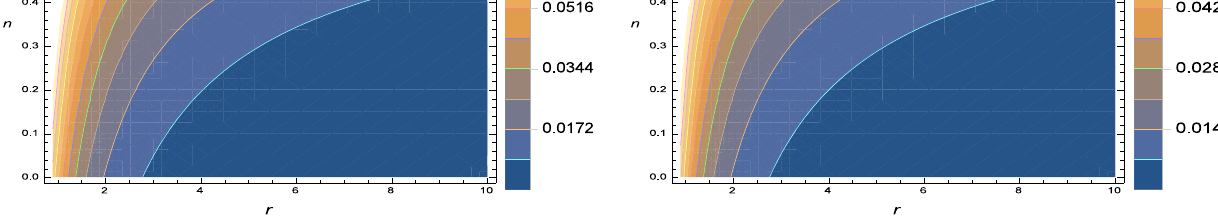
Fig. 4 ρ − p r for Case-I (left) and Case-II (Right)